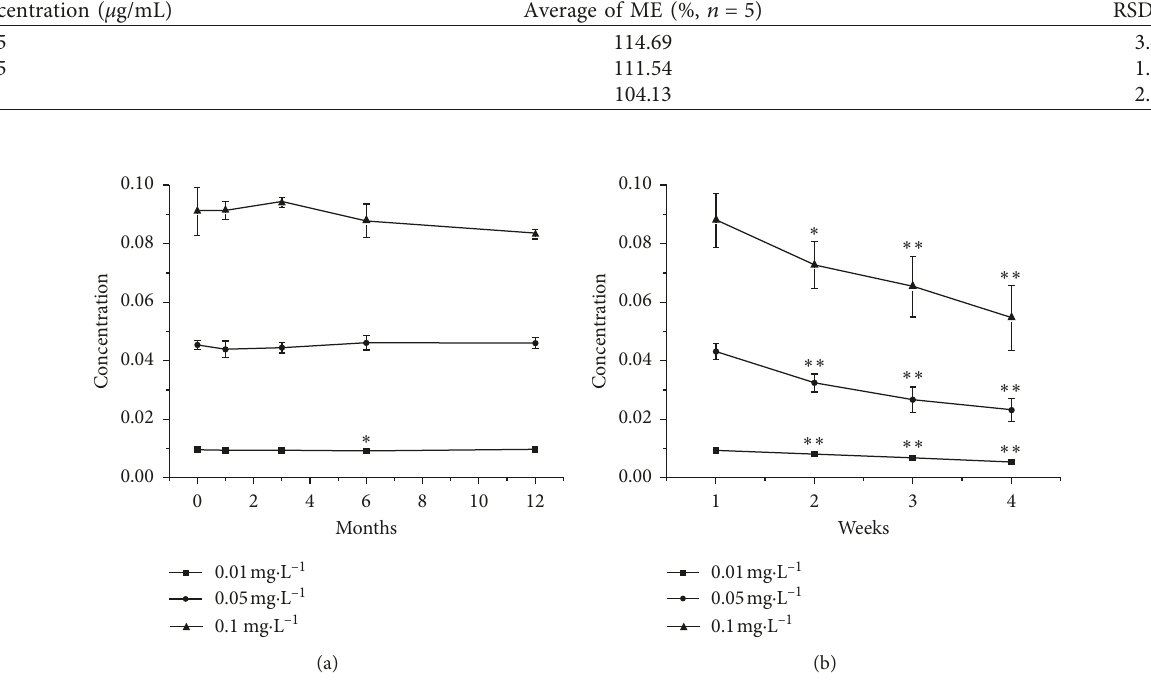
Figure 5: Storage stability of difenoconazole in mango stored at percentage compared to initial values. Values significantly lower than the controls are indicated with a single asterisk (LSD test,